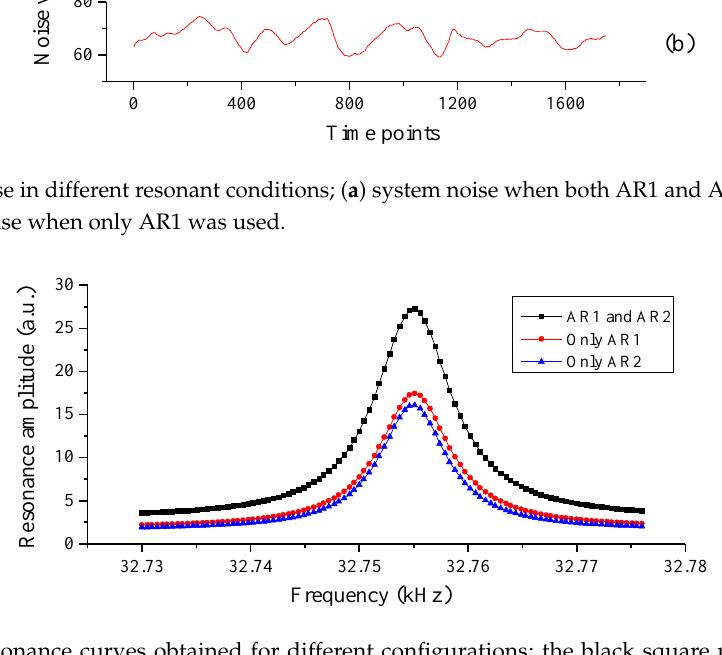
Figure 5. Resonance curves obtained for different configurations; the black square represents the double ARs case; the red dot denotes the case only AR1 was used; the blue triangle is the case AR2 used only.